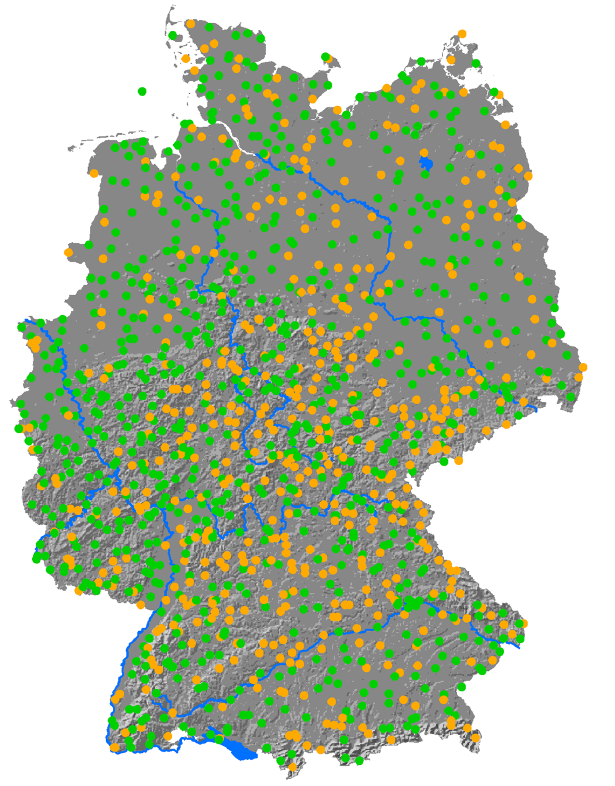
Figure 1. Locations of phenological observation sites and length of their time series. Green: at least 1year of observations. Orange: 50 or more years of